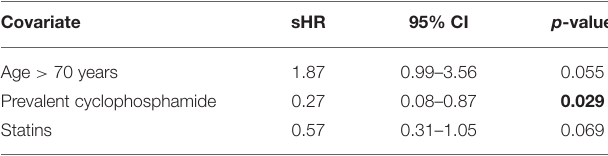
TABLE 4 | Multivariable Fine-Gray model, death without aortic stenosis progression as an event of interest. Covariate sHR 95% CI